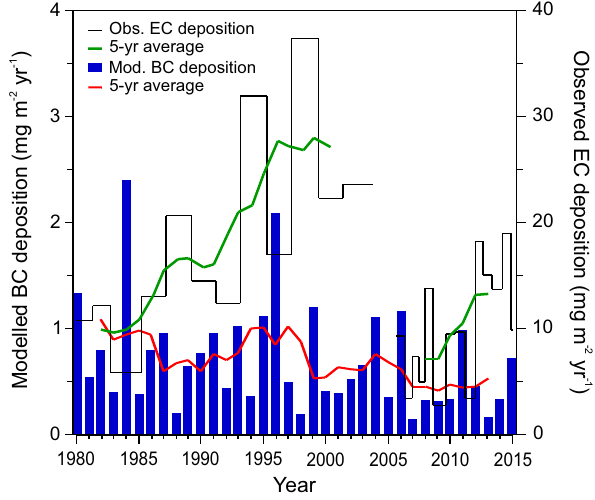
Figure 9. Modelled BC deposition compared to ice and firn core EC deposition at Holtedahlfonna from 1980 to 2015; 5-year running averages are